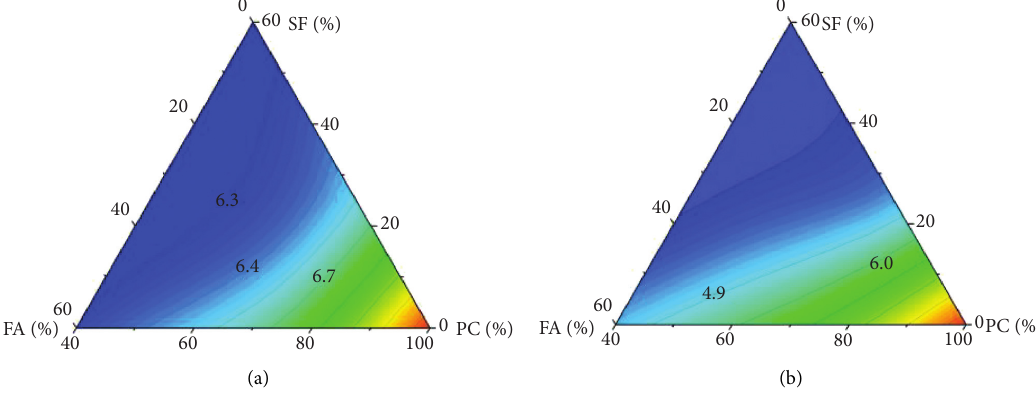
Figure 5: Effects of different cementitious composition on the calcium hydroxide content of UHSC: (a) 3 days and (b) 28